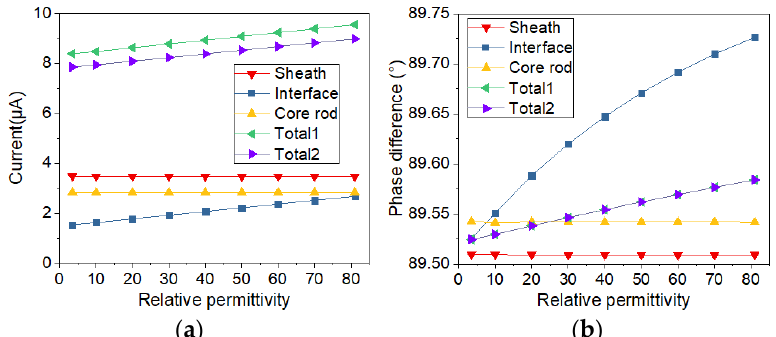
Figure 7. Current varying with relative permittivity of interface gap: ( a ) Change of current; ( b ) Change of phase difference.